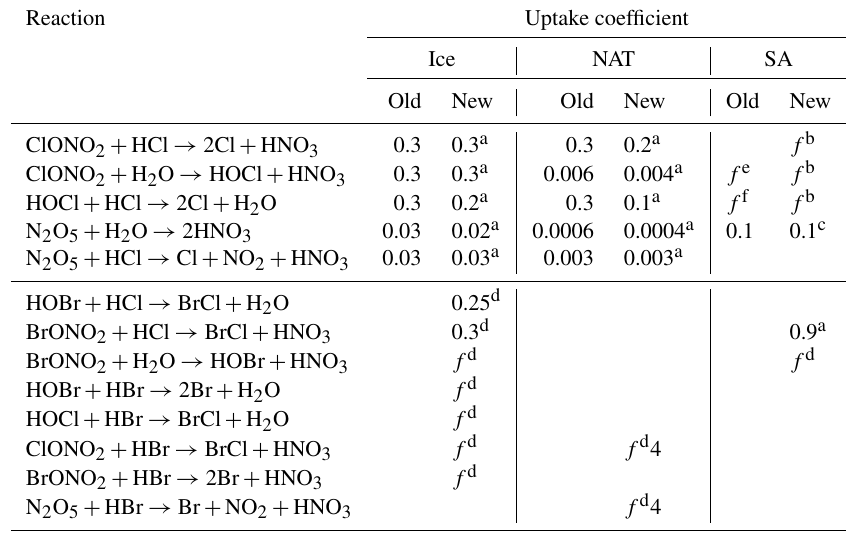
Table 1. Heterogeneous reactions included in the updated UKCA module and the uptake coefficients on ice, NAT and SA. Reaction Uptake coefficient Ice NAT Old